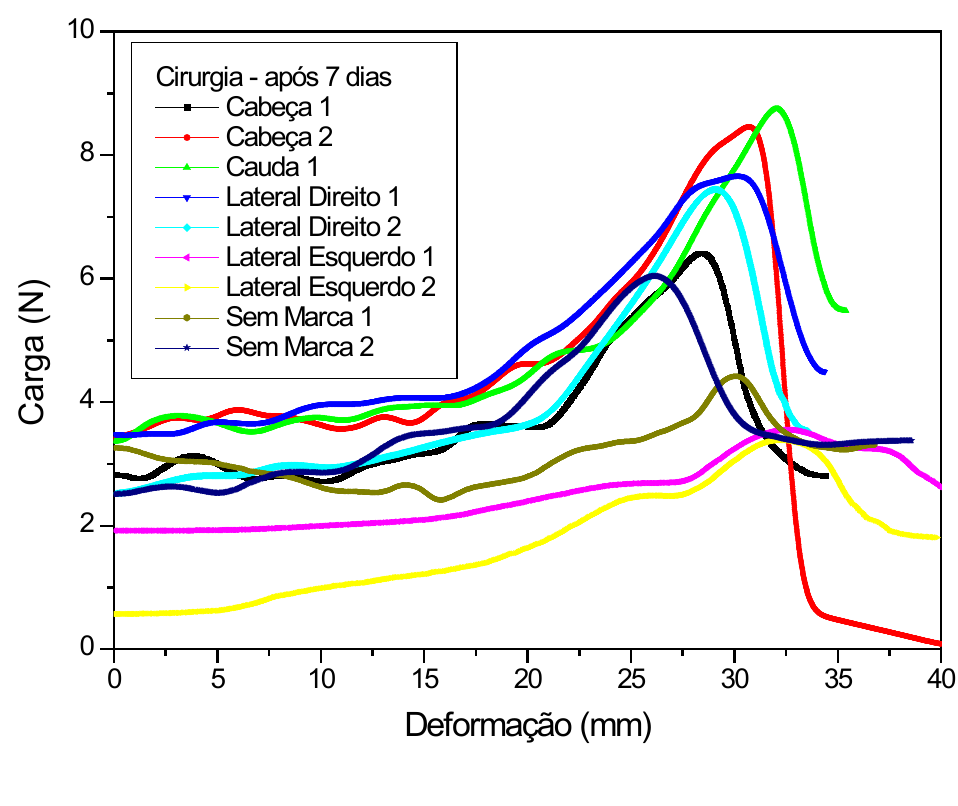
FIGURA 16 – Curva de carga versus deformação no grupo experimento sete